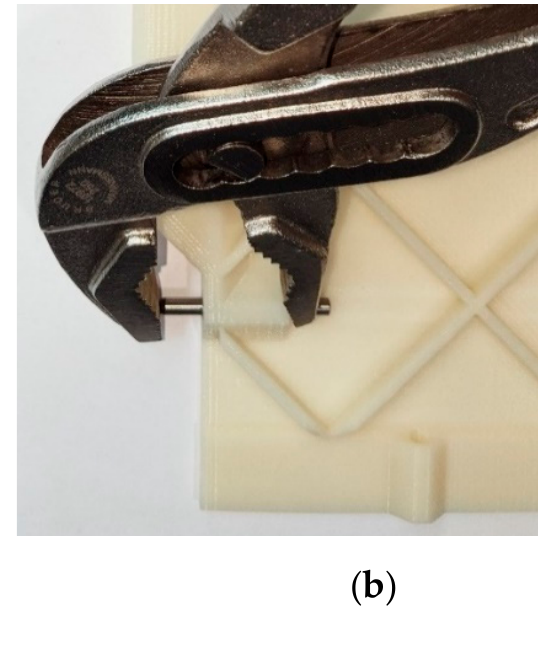
( d ) Figure 19. Assembly procedure for two segments. ( a ) Reaming the pin holes; ( b ) countersinking the pins; ( c ) applying the adhesive; ( d ) aligning the segments and fitting the pins Furthermore, installing the entire assembly and curing it in its final position are pos- sible. After curing of the assembly, the bond is completed and has its final properties. The final assembled part is presented in Figure 20.